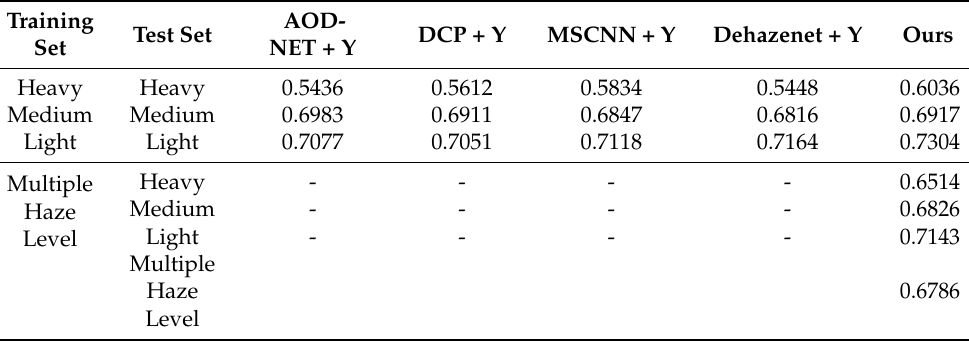
Table 4. The mAP comparison on the different “dehazing + detection” methods at three fog concen- trations and multiple haze level. (Y: YOLOV7).